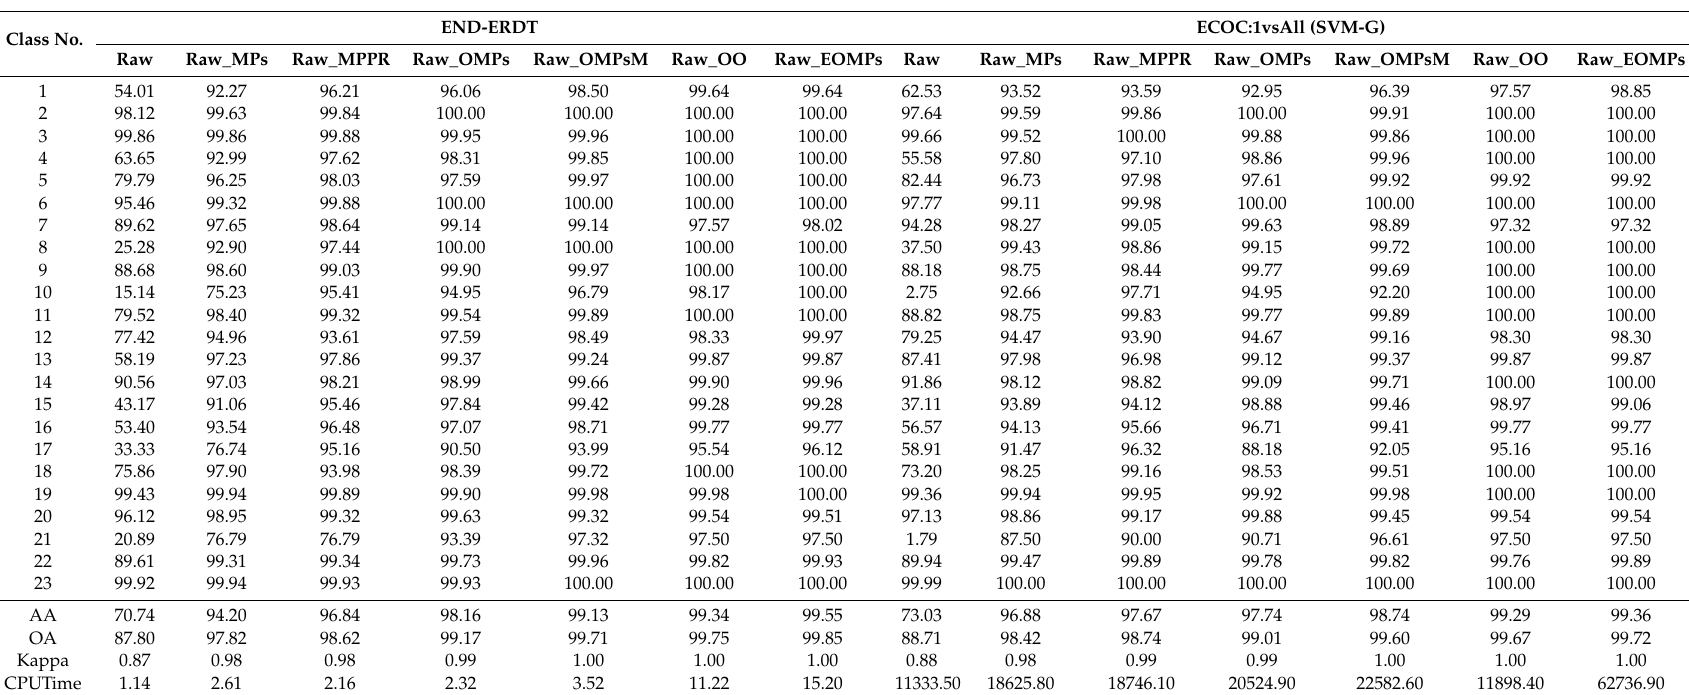
Table 3. Classification accuracy values (user accuracy (UA), average accuracy (AA), OA, and kappa) for the considered methods in the study area. Class